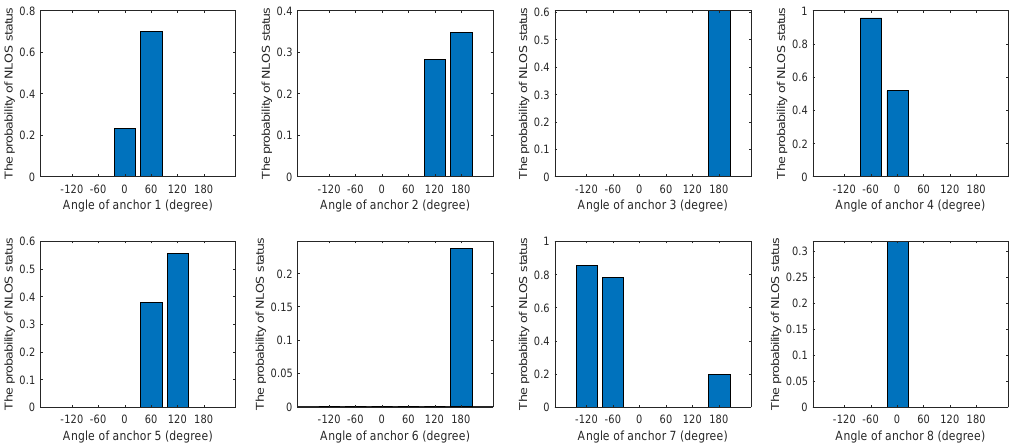
Figure 3. The relationship between the probability of NLOS status and angle in eight